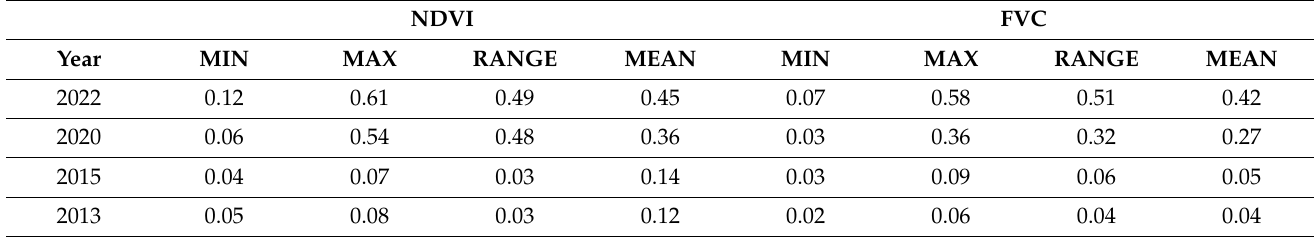
Table 3. Statistics (masked by the built green town subsurface) of the normalized difference vegeta- tion index (NDVI) and fractional vegetation cover (FVC) changes according to the studied years. NDVI